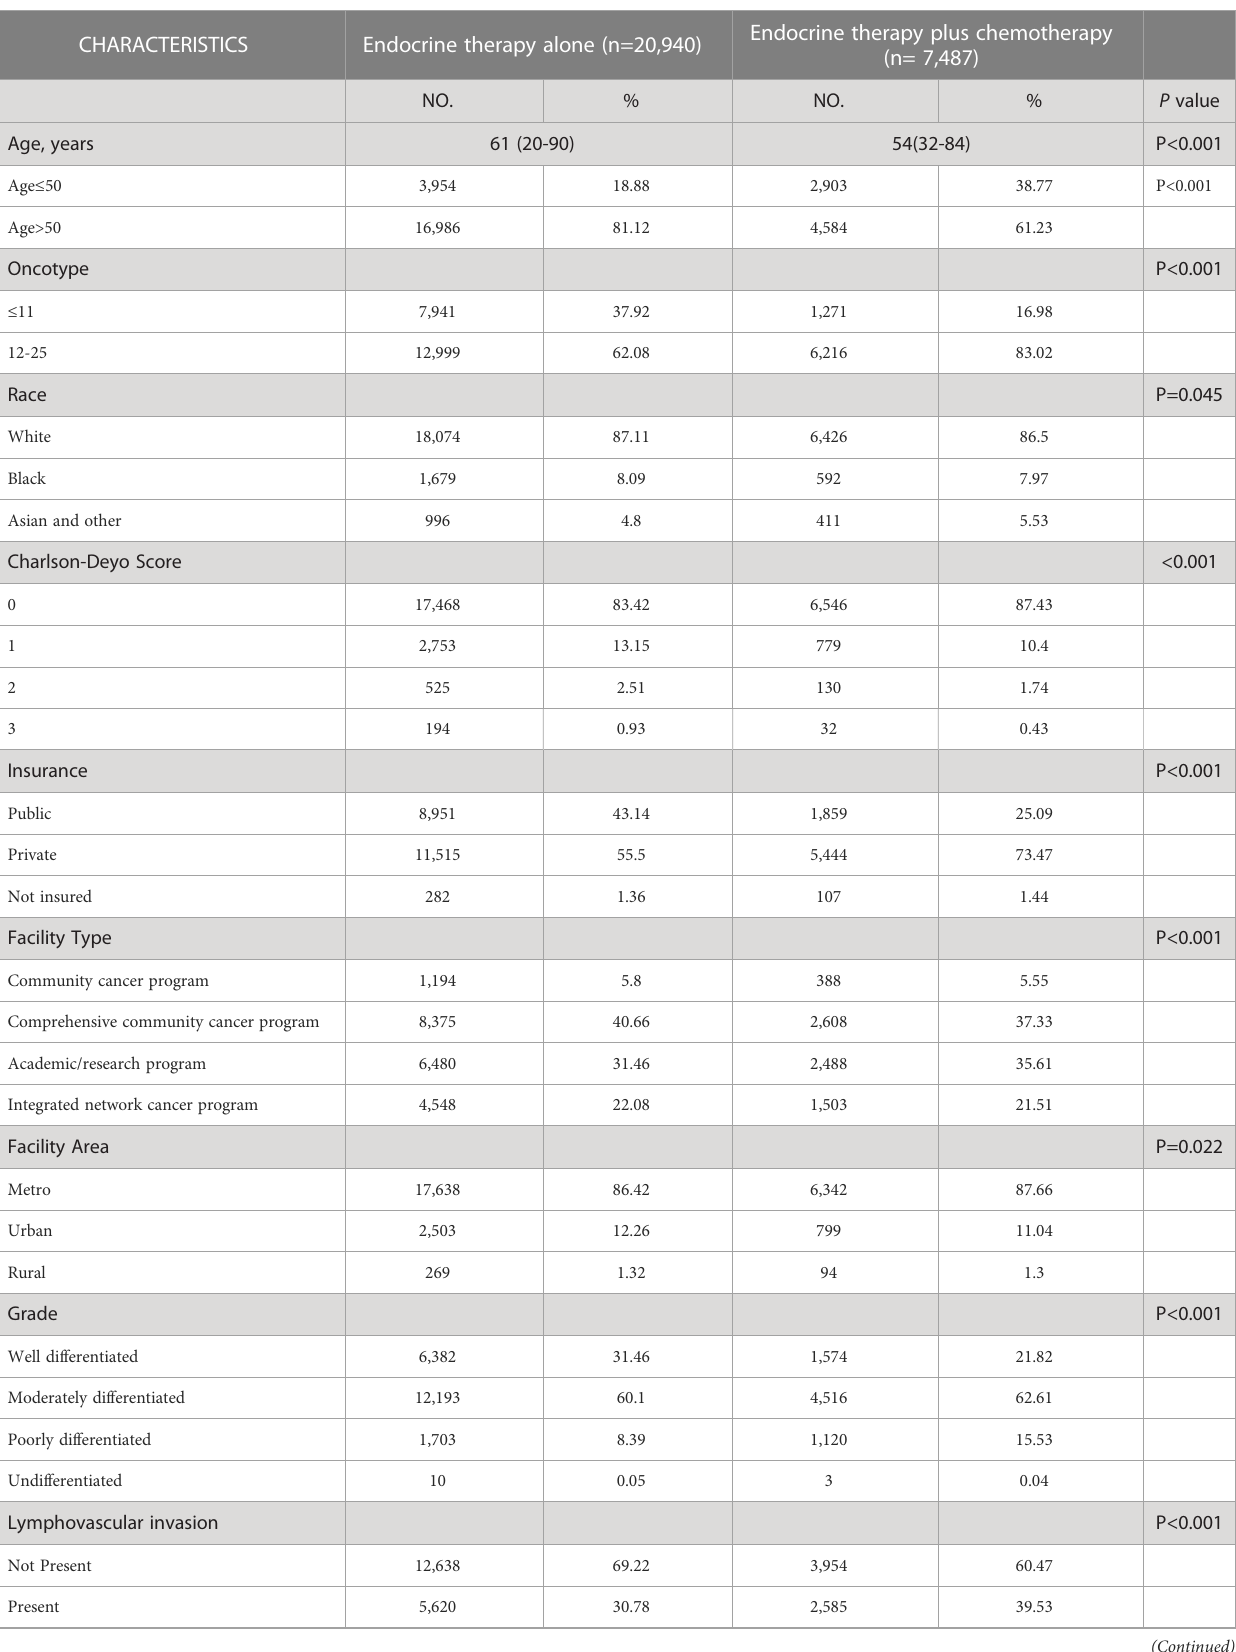
TABLE 1 Demographic, clinical and treatment characteristics of pathological stage I-III HR+HER2- breast cancer patients with 1 – 3 positive nodes, NCDB 2004-2018.